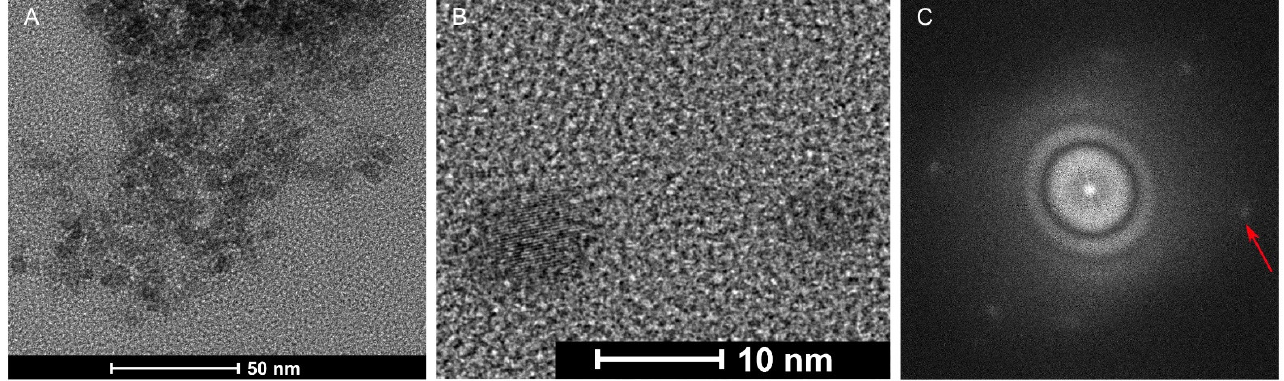
Figure 4. Transmission electron microscopy (TEM) images of gCDs. ( A ) TEM at 50 nm scale; ( B ) TEM at 10 nm scale allowing the observation of lattice fringes in the nanoparticles; ( C ) Fourier transform of the particles observed in image ( A ). The red arrow points to the white dots in the Fourier transform that indicate a crystalline